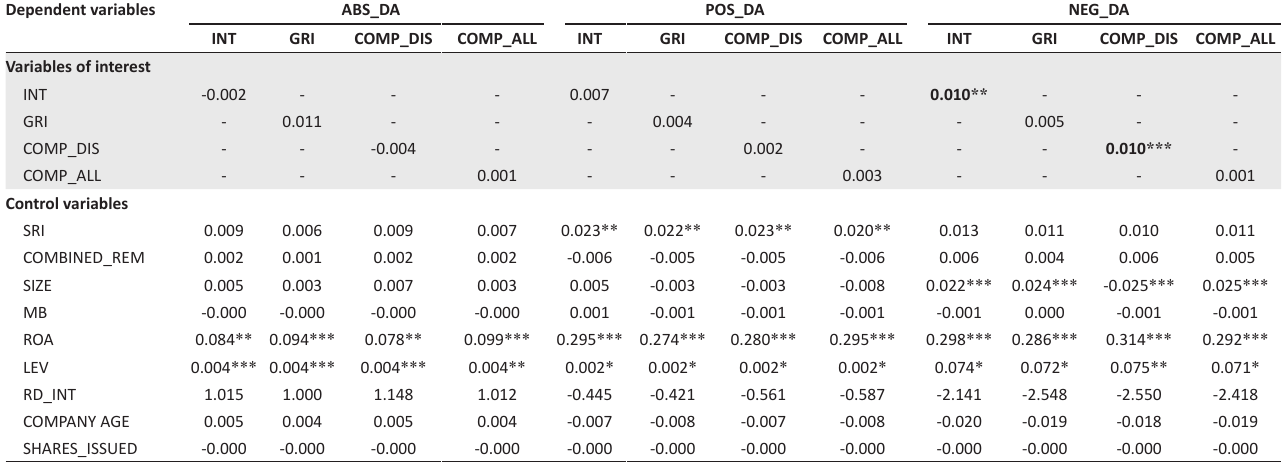
TABLE 6: Accrual-based earnings management on corporate social responsibility disclosure. Dependent